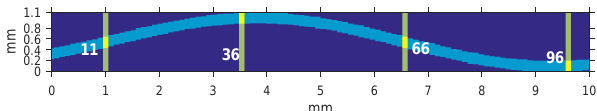
Figure 5. Indication of four scans which are presented in more detail. There were 100 scans in total, each of the indicated scans has its number denoted